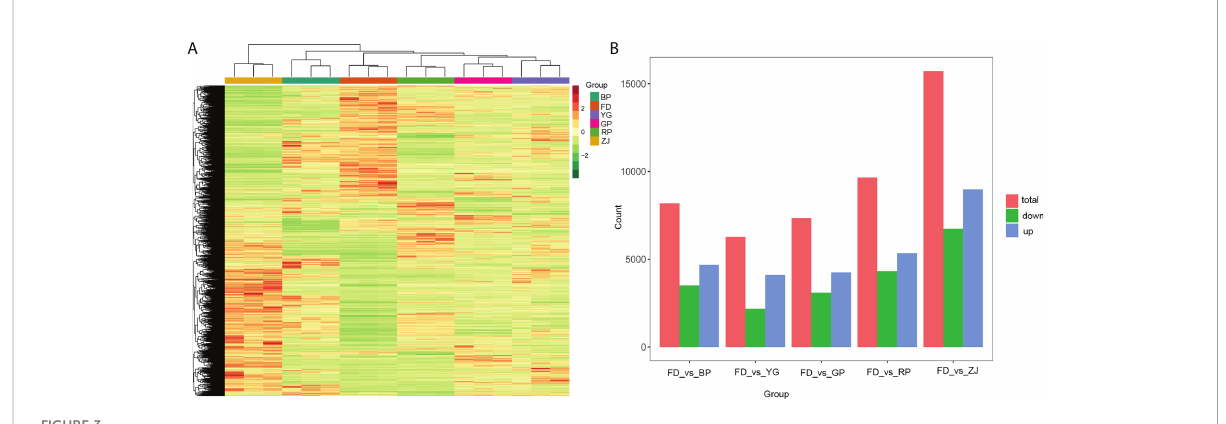
FIGURE 3 Differentially expressed genes (DEGs) at various sample groups. (A) The cluster analysis of all DEGs; (B) DEGs among ‘ FD ’ _ vs _ ’ BP ’ , ‘ FD ’ _ vs _ ’ YG ’ , ‘ FD ’ _ vs _ ’ GP ’ , ‘ FD ’ _ vs _ ’ RP ’ and ‘ FD ’ _ vs _ ’ ZJ ’